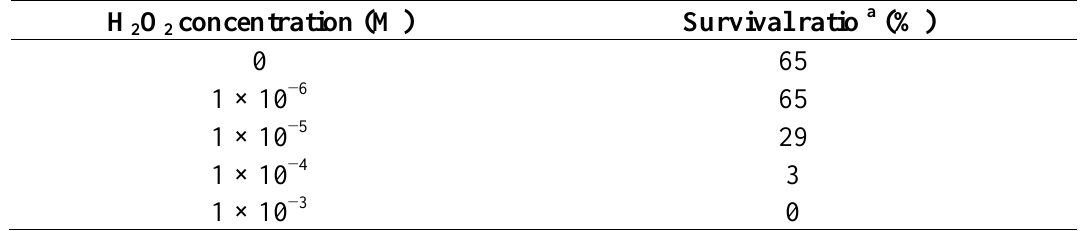
Table 1. Bactericidal effect of H with permission from Elsevier, ©